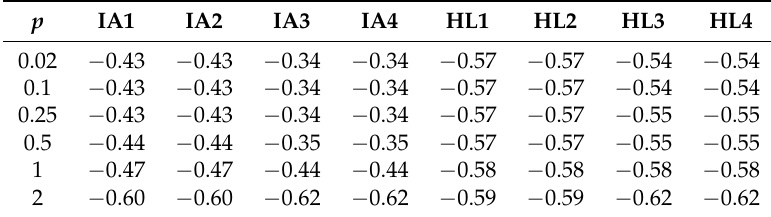
Table 7. 2PL Linking Study: Group Mean Corresponding to Form Y